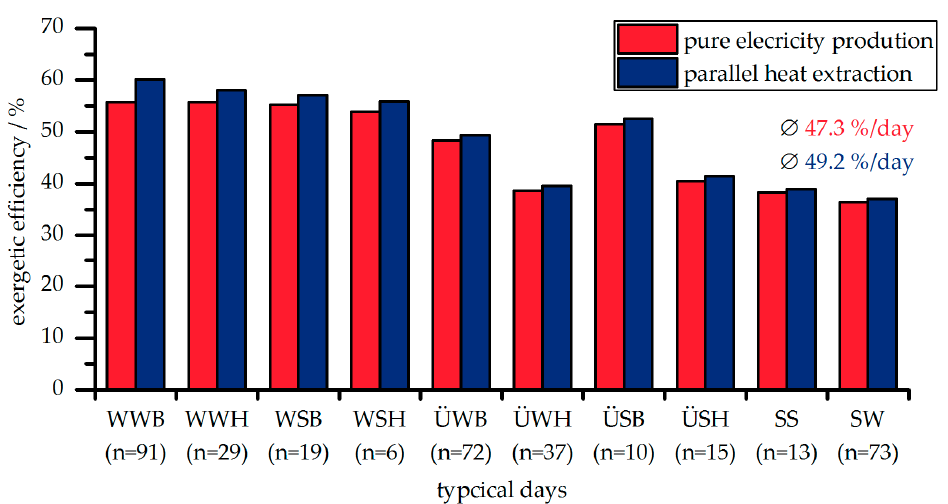
Figure 7. Exergetic efficiency of each typical day for pure electricity production and parallel heat extraction.